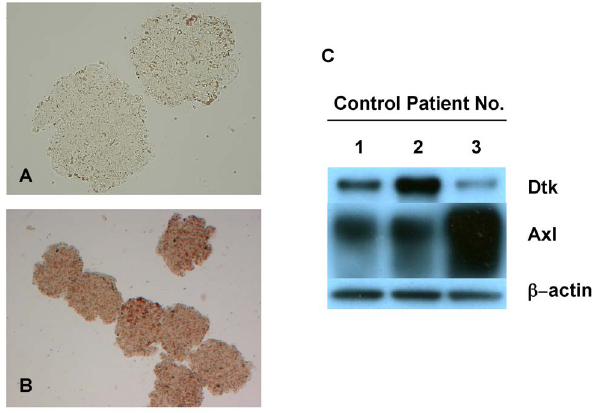
Figure 5. Expression of Dtk and Axl in control glomeruli. (A,B) Photographs of isolated glomeruli. The glomeruli were isolated from the uninvolved portion of tumor nephrectomy specimens by sieving method from three patients. The relative purity of isolated glomeruli was shown. The original magnification was (A) X100. (B) X50. (C) Ten m g of each glomerular lysate was analyzed by westernblotting with the antibodies indicated. Dtk and Axl were expressed in normal glomeruli.